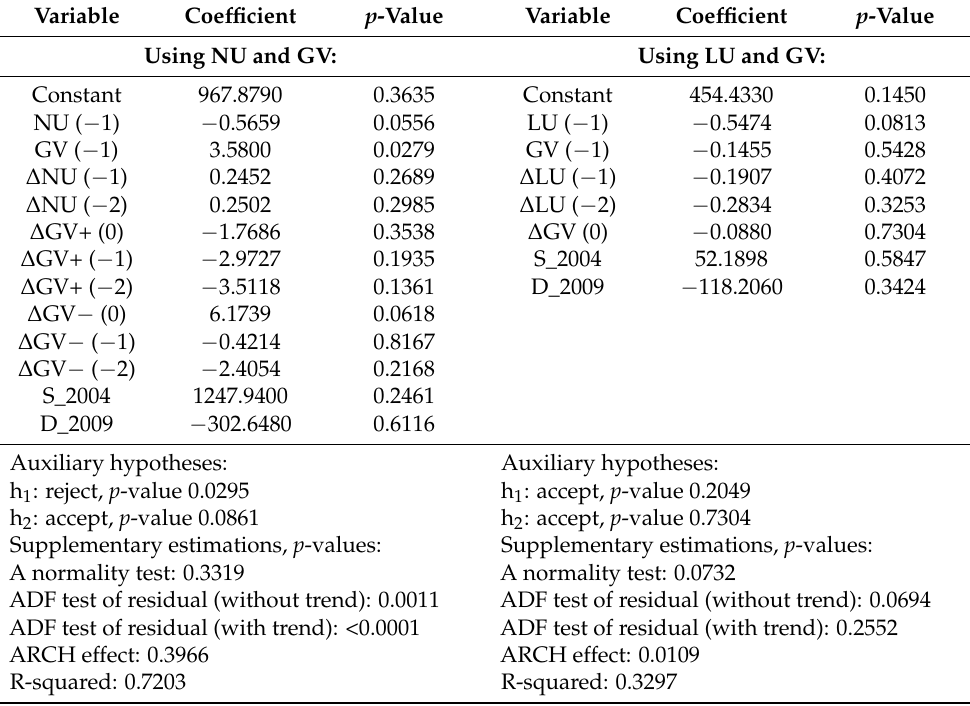
Table 7. Non-linear autoregressive distributed lag (NARDL) estimations for Estonia. Variable Coefficient p -Value Variable Coefficient p -Value Using NU and GV: Using LU and GV: Constant 967.8790